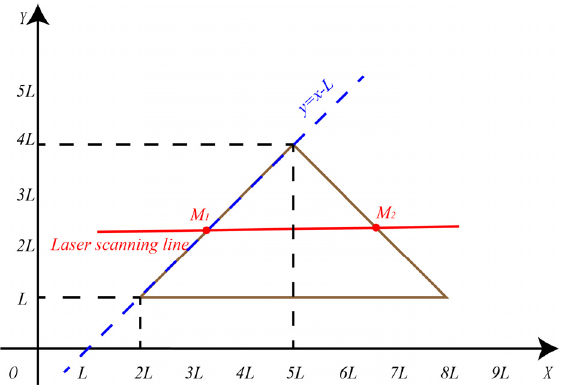
Figure 4. Solution of feature point coordinate on calibration board.